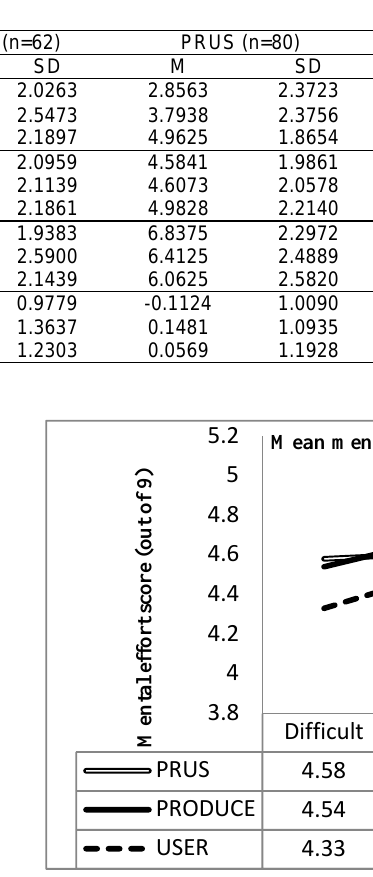
Table 1. Mean (and SD) test performance, mental effort and instructional efficiency scores per condition with different level of difficulty.